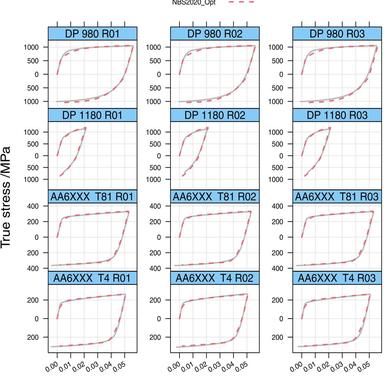
Comparison of measured true stress vs. true strain data and FEA-computed true-stress-true-strain data determined using the Y-U parameters from the Numisheet Benchmark Study 2020 Method, abbreviated NBS2020_Opt, for top to bottom: DP 980, DP 1180, AA6XXX-T81, and AA6XXX-T4.